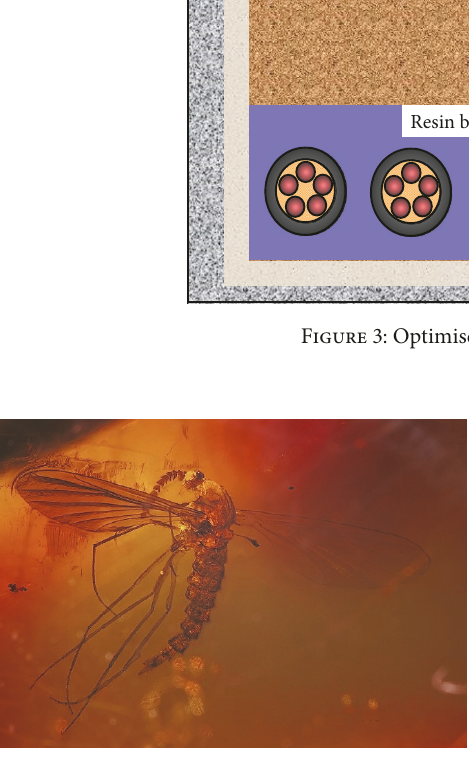
Figure 4: Example of insect preserved in amber for millions of years (image https://commons.wikimedia.org/wiki/File:Ambre Dominique